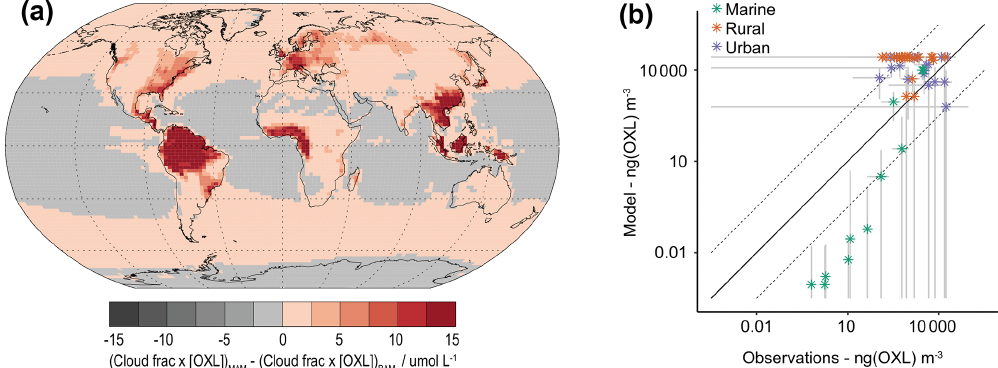
Figure 11. (a) Relative difference in organic ligand reaction on in-cloud iron aerosol dissolution between MIMI and BAM-Fe. Due to significant differences in simulated cloud cover between CAM4 and CAM5 oxalate concentrations [OXL] are multiplied by the model- simulated cloud fraction in this figure. (b) Surface-level oxalate (OXL) concentration in the model and observations. Model values are monthly mean (2007–2011) and annual standard deviation. Observation values are from Table S3 in Myriokefalitakis et al. (2011) and reported with uncertainty where given. Table 8. Global and regional ocean basin deposition (Gga − 1 ) of total and soluble iron in BAM-Fe (Scanza et al., 2018) and MIMI (this study). Deposition was multiplied by the ocean fraction of model grid cells and is reported at two significant figures. The percent contribution from pyrogenic (sum of fires and anthropogenic combustion) iron sources to deposition is also given. Ocean basins are those defined by Gregg et al. (2003) and previously used by Scanza et al.